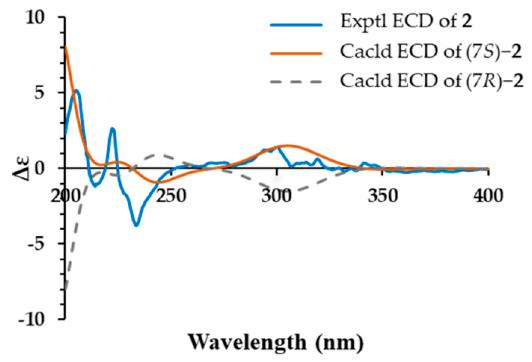
Figure 4. Experimental and calculated ECD curves of compound 2 .